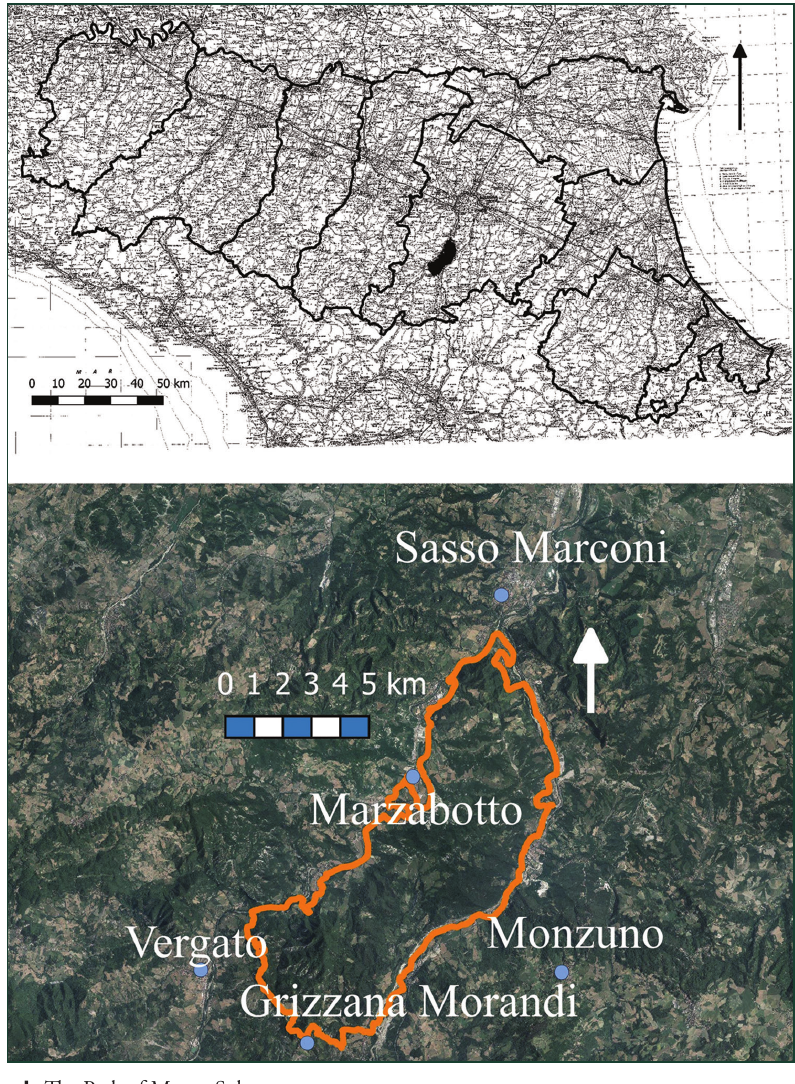
Figure 1. The Park of Monte